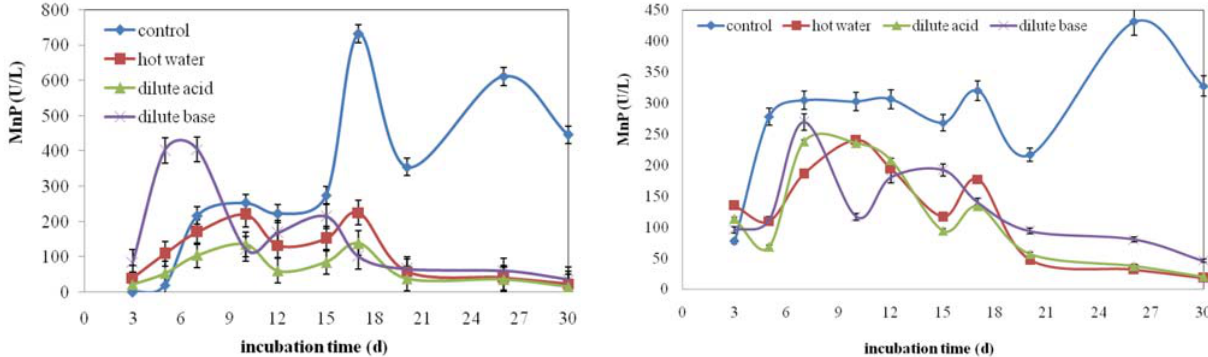
Figure 4. Variations of MnP activities depending on peach (left side) and cherry (right side) cultures. The values are the mean ± SD for experiments of three separate